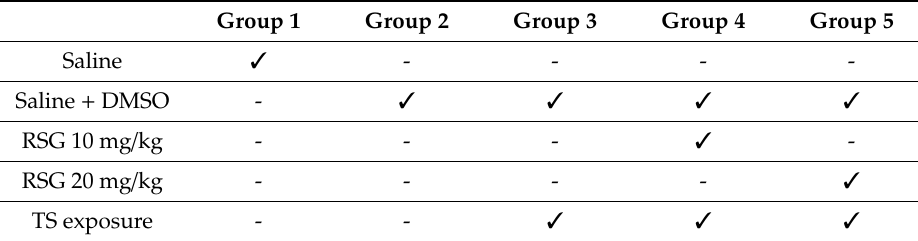
Table 1. Experimental